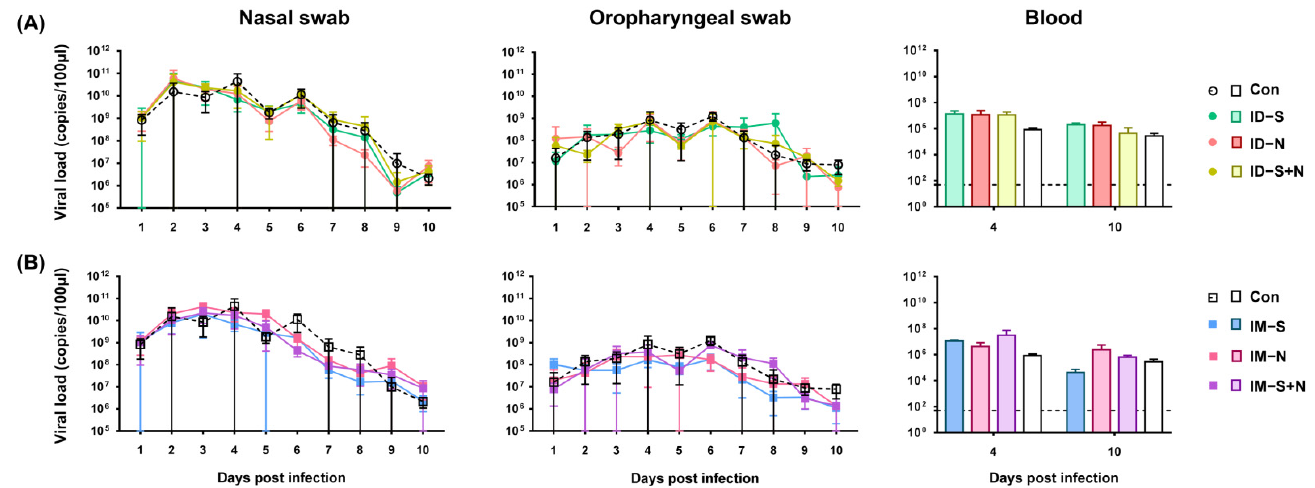
Figure 4. Viral shedding and viremia in hamsters immunized with the recombinant proteins via the ID and IM routes after SARS-CoV-2 challenge. ( A ) Challenge after ID and ( B ) challenge after IM. RNA was extracted, and the viral load was determined as copies per 100 μ L. The dotted line in the figure indicates a PCR detection threshold of 50 copies/100 μ L ( n = 10 per group for nasal swabs and oropharyngeal swabs, and n = 3 per group for each blood-monitoring time point).